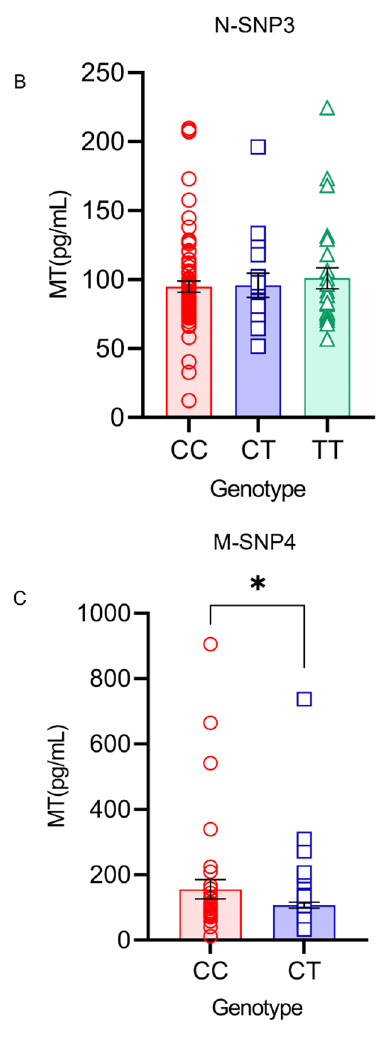
Figure 4. MT levels in the serum under different genotypes within the AANAT and ASMT genes. * ( p < 0.05) show a significant difference. ( A ) Serum MT level of N-SNP2 within AANAT . ( B ) Serum MT level of N-SNP3 within AANAT . ( C ) Serum MT level of M-SNP4 within AANAT .